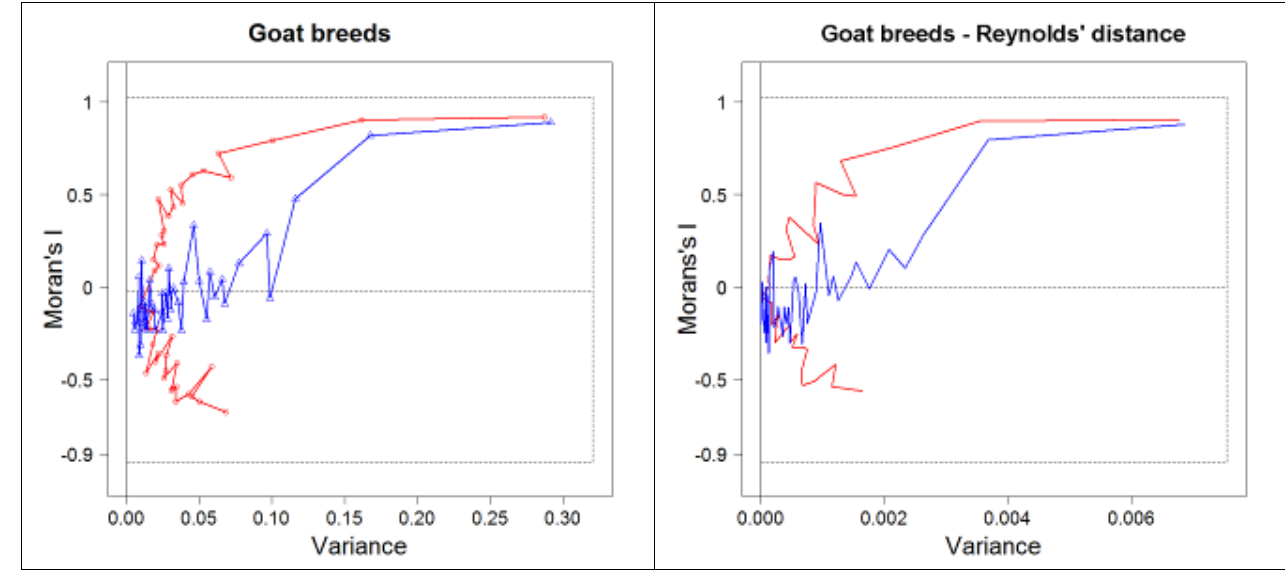
Figure 2. Scatter plots of spatial Moran’s I and variance components of eigenvalues of PCA or MDS. For each plot, the blue and red lines correspond to the ordinary and spatial analyses, respectively. Top left, bottom left, and right: PCA and sPCA on allele frequencies. Top right: MDS and sMDS on Reynolds’